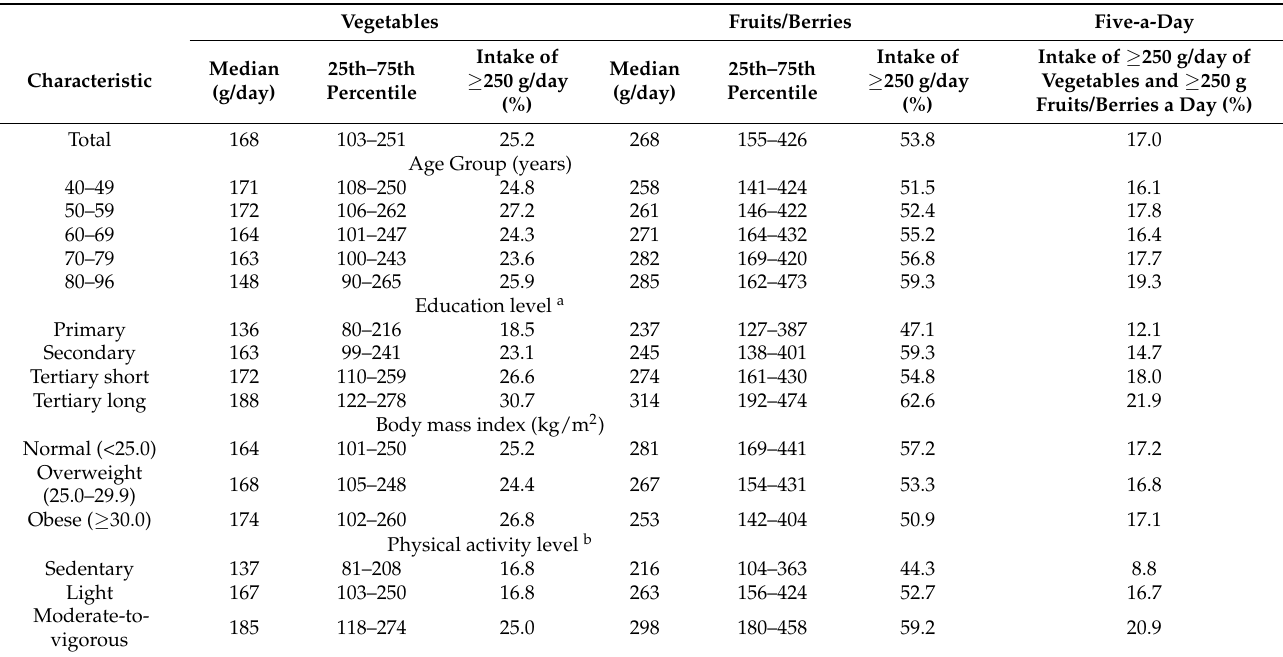
Table 3. Median intake of vegetables, fruits and berries in men, and proportion compliant with recommendations. The Tromsø Study 2015–2016.